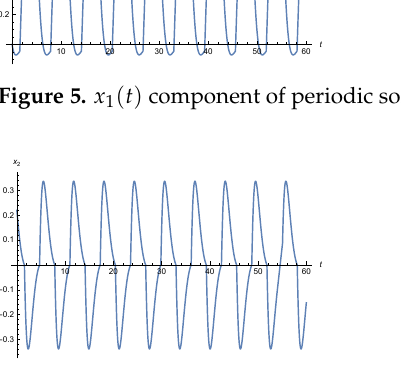
Figure 6. x 2 ( t ) component of periodic solution of (55) with ε =